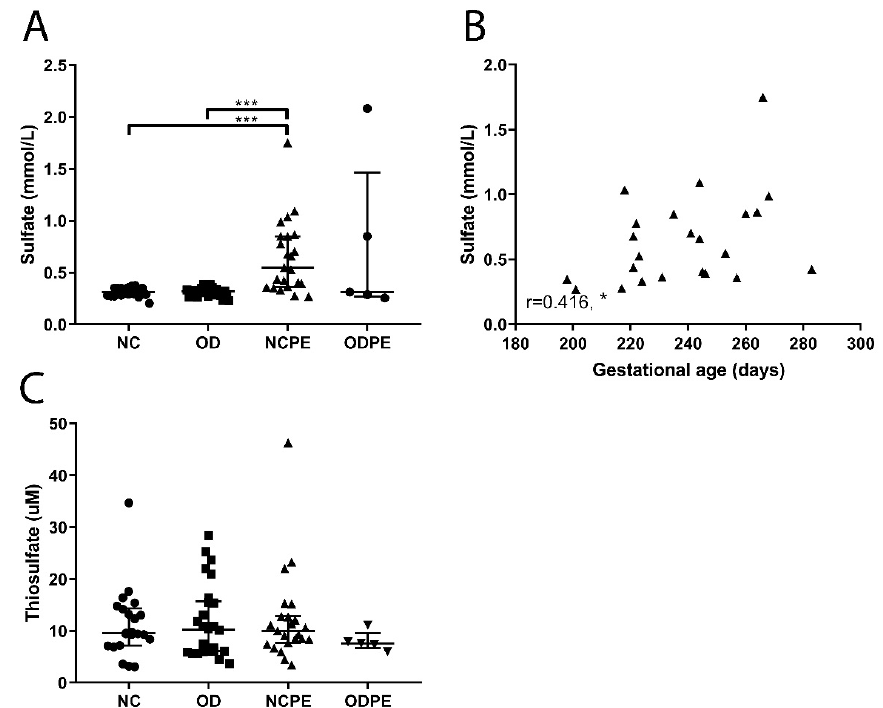
Figure 3. Readouts of the hydrogen sulfide (H 2 S) pathway. ( A ) Sulfate (SO 42− ) values were higher